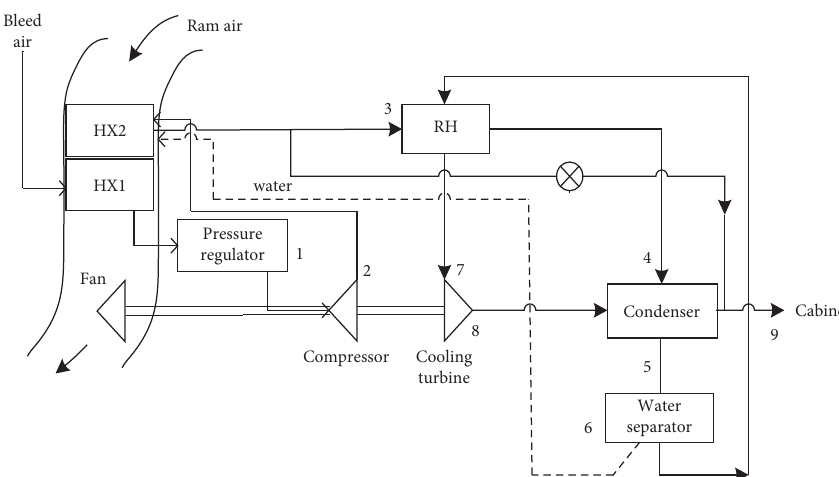
Figure 2: Three-wheel boost system.